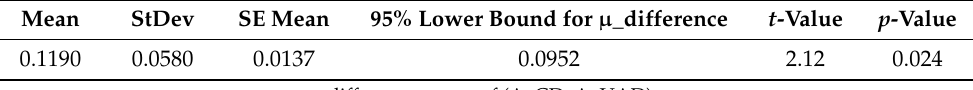
Table 5. Paired t -test for difference of the chip-evacuation coefficient, A between CDs and UADs. Mean StDev SE Mean 95% Lower Bound for µ _difference t -Value p -Value 0.1190 0.0580 0.0137 0.0952 2.12 0.024